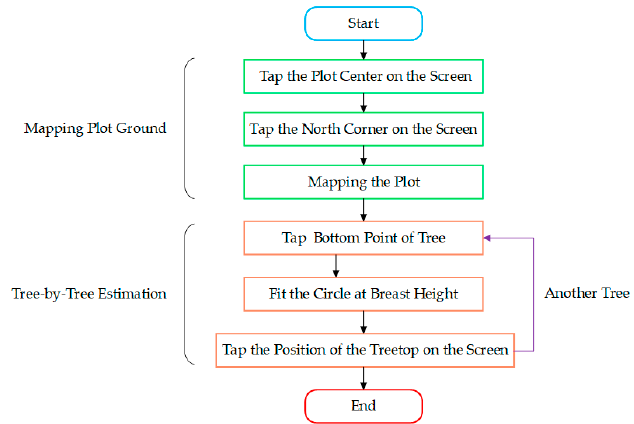
Figure 5. The workflow of the forest inventory system for data acquirement.